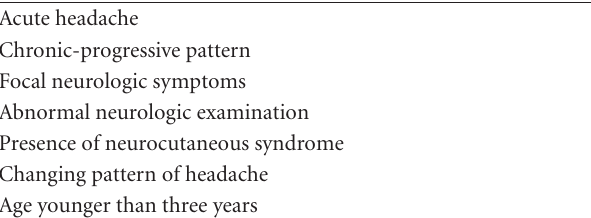
Table 3: Di ff erentiating Migraine from Tension-type headache. Table 4: Indications for neuroimaging in children with